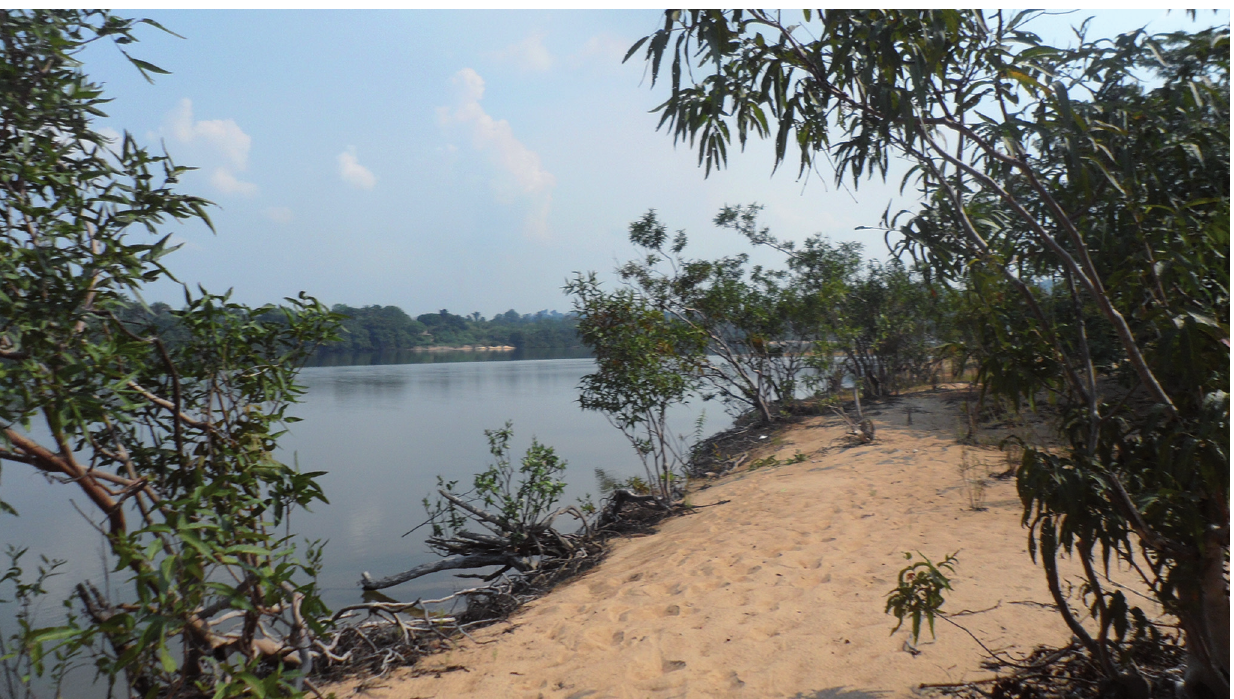
Fig. 5. Type locality of Crenicichla anamiri on the beach on rio Xingu, Itapuama, below the confluence between rio Xingu and rio Iriri, with roots of marginal trees. Photo taken during the Xingu expedition in the dry season (November